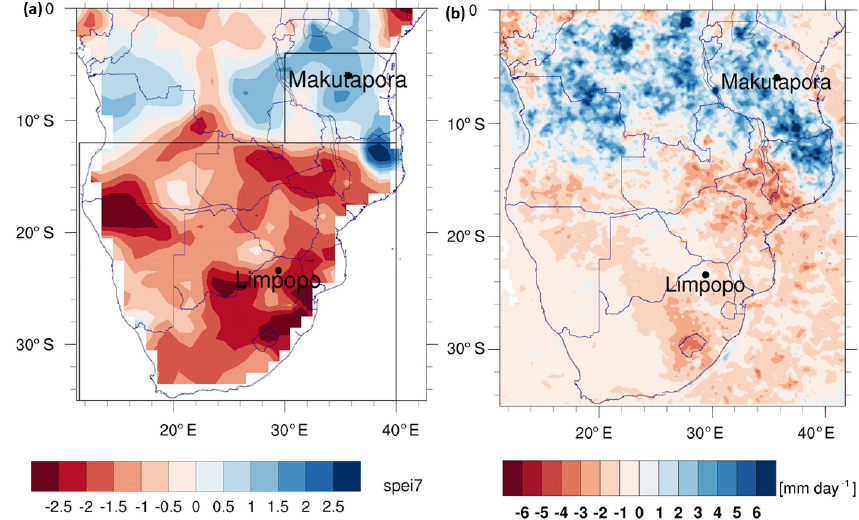
Figure 1. Large-scale climate anomalies over the study region for October–April 2015–2016. (a) SPEI-7. (b) Anomalies of the 80th percentile of daily TRMM rainfall (mmday − 1 ). Boxes in (a) show the EASE (small box) and SA (large box) domains used in the SPEI-7 IAF analysis (see Sects. 2.1 and S2). The piezometer observation locations are also